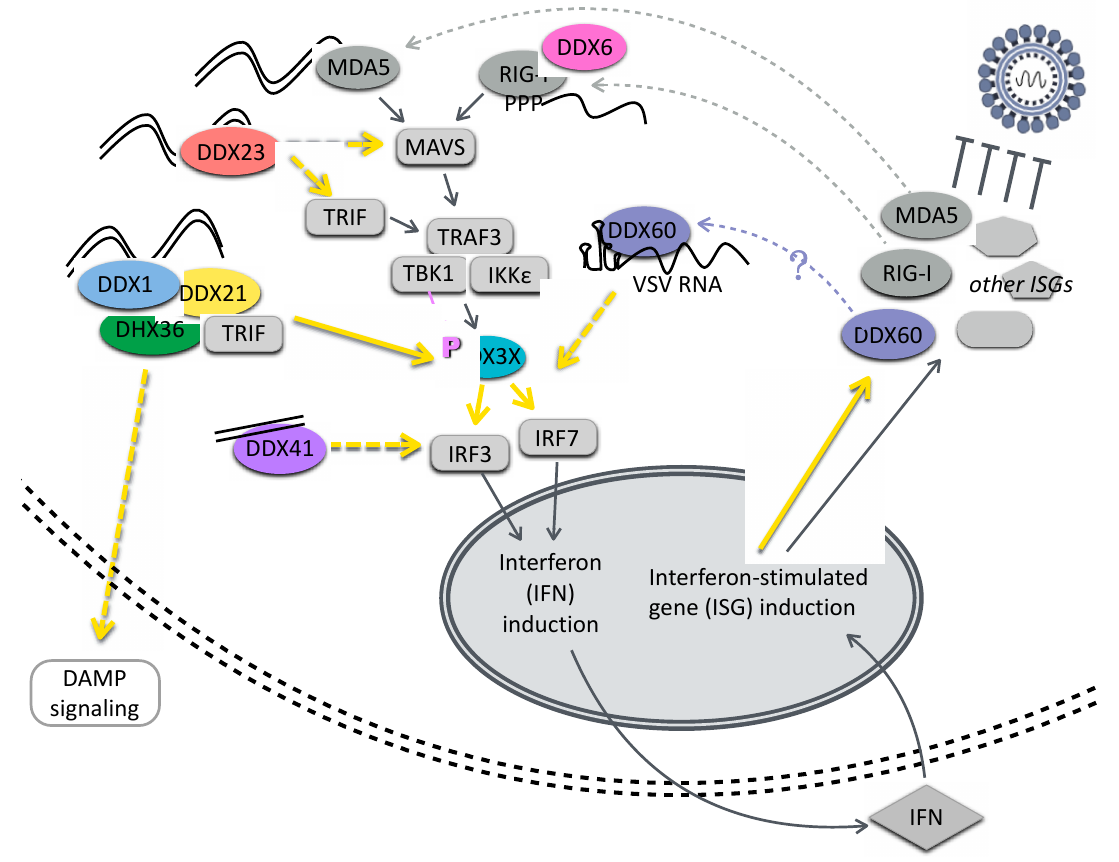
Figure 1. DEAD-box helicases contribute to innate immune signaling. DEAD-box helicases have been demonstrated to serve as sensors for nucleic acids, including dsRNA, cytoplasmic DNA, and viral RNAs, leading to the induction of interferon and interferon-stimulated genes. DEAD-box helicases also contribute to innate immune signaling downstream of nucleic acid sensing by mediating protein–protein interactions and promoting DAMP signaling. Moreover, some DEAD-box helicases are ISGs, suggesting positive feedback on their innate immune roles. RIG-I and MDA-5, while considered members of the RIG-I-like receptors (RLR) family, contain related DExD / H-box RNA binding domains. DEAD-box helicases are shown in color and other cellular components are shown in gray. Dotted yellow lines are used where there may be intermediate steps in the indicated relationship. (DAMP, damage-associated molecular pattern; IFN, interferon; ISG, interferon-stimulated gene; TLR, toll-like receptor; VSV, vesicular stomatitis